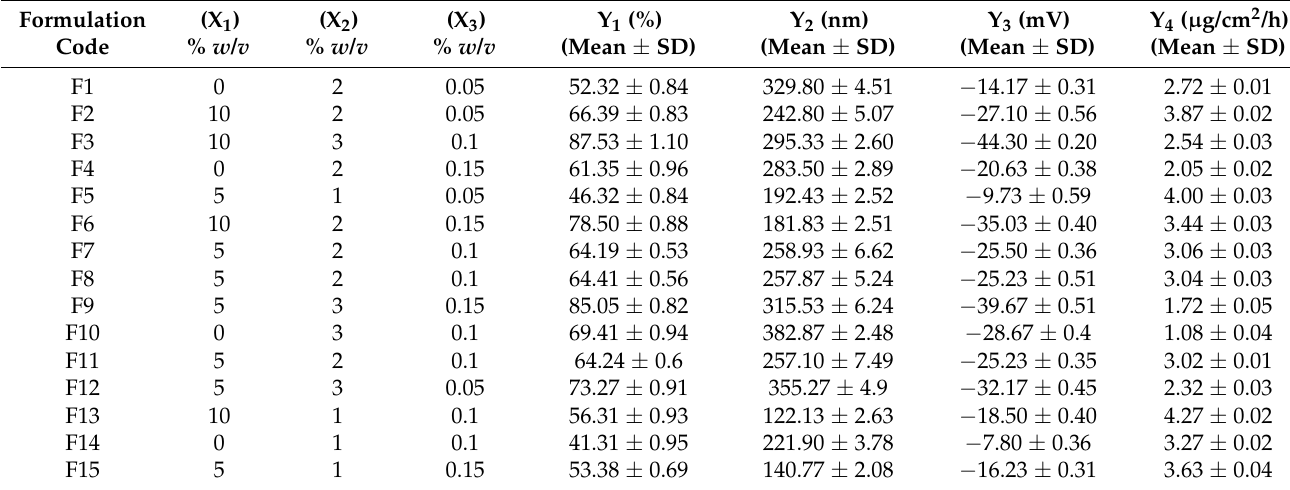
Table 1. Composition of various RLDL formulations as well as their